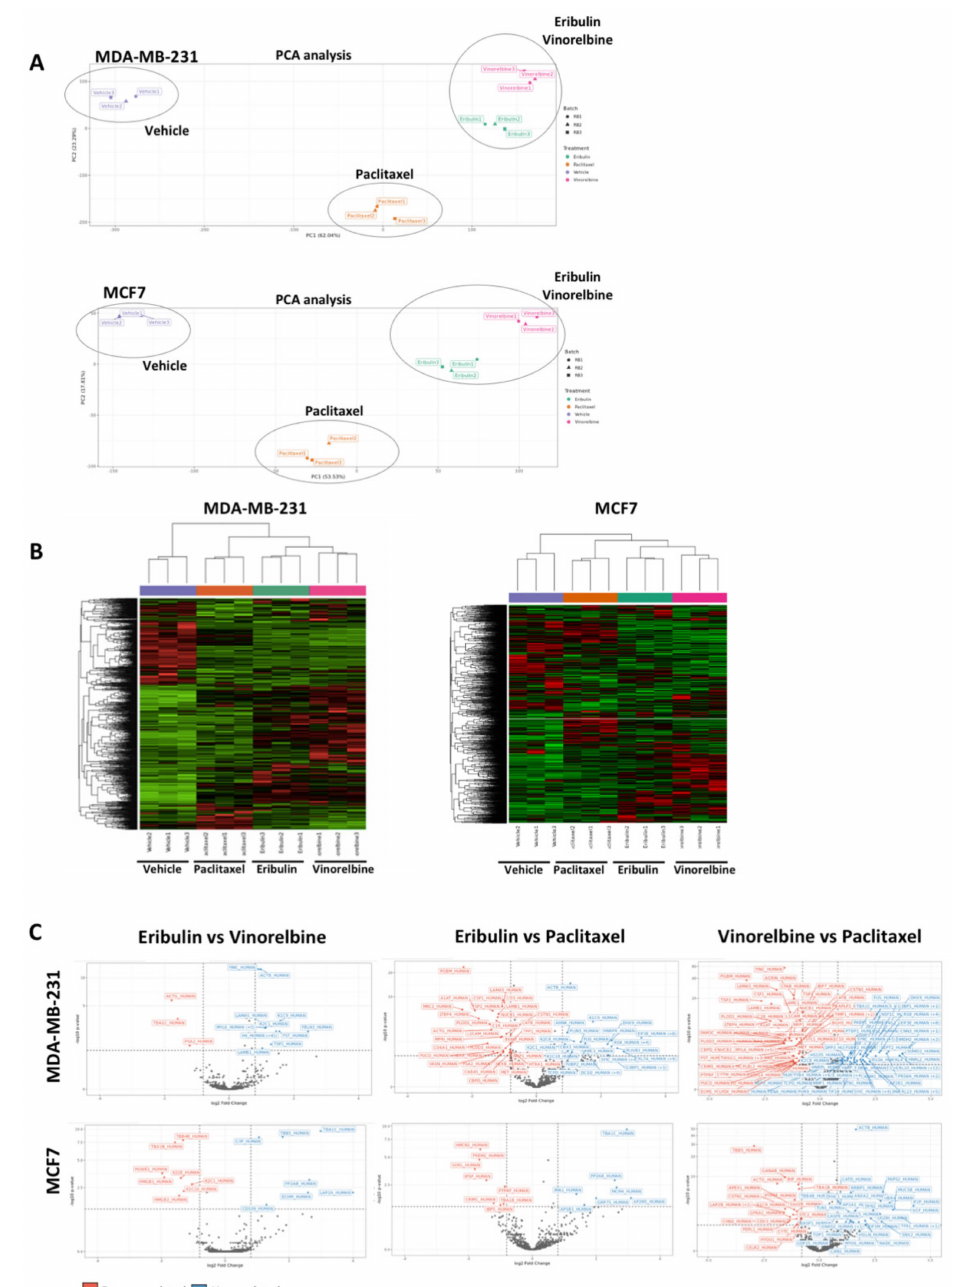
Figure 3. MTAs that share the same mechanism of action are characterized by a similar secretome profiling. ( A ) Representative image of the principal component analysis (PCA) of the three MTAs treatment plus vehicle (control) induced secretome. The analysis shows clear separation by treatment and a higher similarity of eribulin and vinorelbine treatment compared with paclitaxel treatment. Analysis was performed in three biological replicates (Supplemental data). ( B ) Heat maps of hierar- chical clustering analysis of the different MTA treatments. The analysis confirms the clustering of eribulin and vinorelbine treatment compared with paclitaxel treatment. Analysis was performed in three biological replicates (Supplemental data). ( C ) Volcano plots of inferential analysis confirmed that differentially over-secreted proteins were obtained from the eribulin versus paclitaxel comparisons than from the eribulin versus vinorelbine one in the secretome of MDA-MB-231 and MCF7 cell-line models. Adjusted p -value < 0.05, fold change > 0.8 and number spectral counts (SpC) > 4 thresholds were applied during the